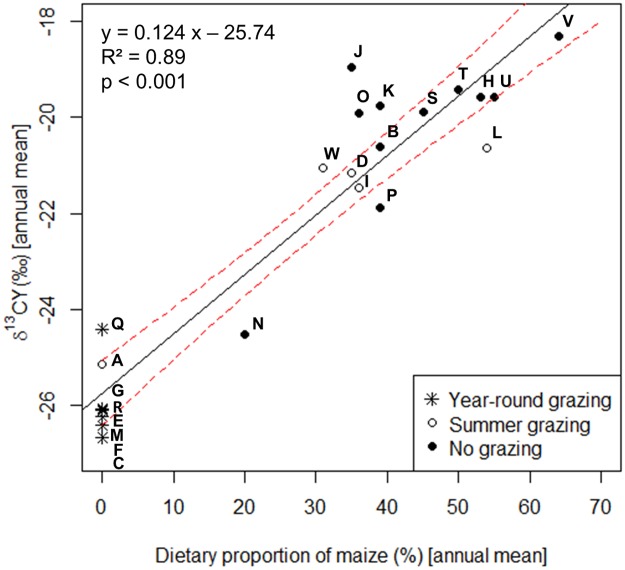
Relationship between δ13CY values in cattle hair and annual dietary proportion of maize (% dry matter).Each point refers to a farm. The letters A-W indicate the farms (see Table 1). The solid and dotted lines refer to regression line and 95% confidence interval (CI), respectively (RSE = 0.98).